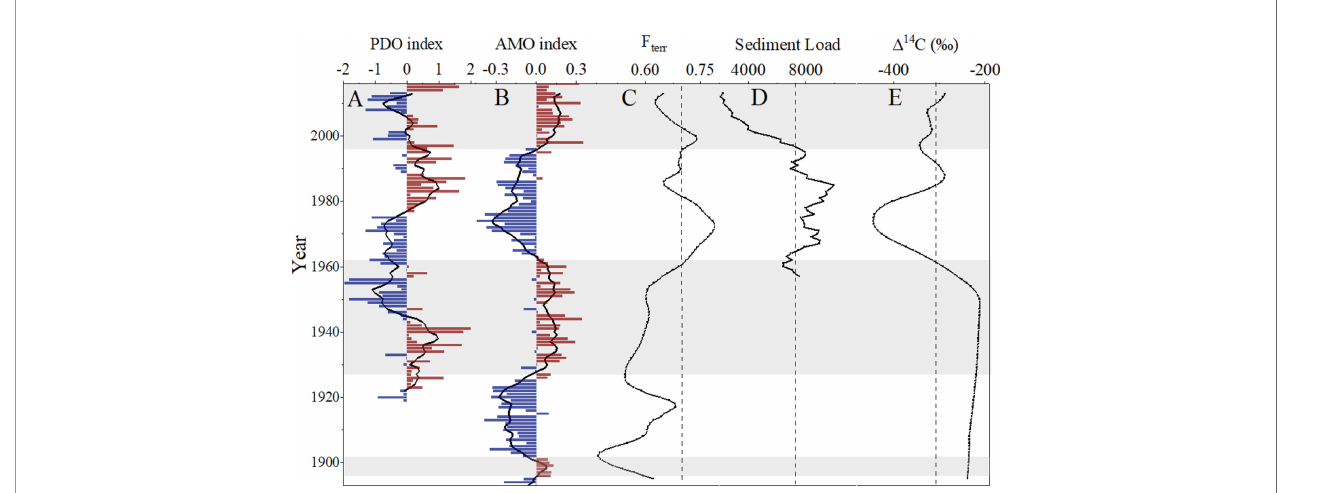
FIGURE 7 | (A) Paci fi c Decadal Oscillation (PDO) index; (B) Atlantic Multidecadal Oscillation (AMO) index; (C) Fraction of total terrestrial OC (F terr , %) from Monte Carlo simulation; (D) Sediment load (10 4 t yr -1 ) of Pearl River, modi fi ed from Wei et al. (2020); and (E ) D 14 C ( ‰ ). The interpolation method was applied for data processing. The values for the PDO index were taken from University of Washington (http://jisao.washington.edu/pdo/PDO.latest) (Duan et al., 2013). The AMO index is downloaded from Earth System Research Laboratory (http://www.esrl.noaa.gov/psd/data/correlation/amon.sm.data). The bars were annual index value. The black curves represented 7 year running mean value in (A, B) The monthly mean global average sea surface temperature (SST) anomalies have been removed to separate this pattern of variability from any global warming signal that may be present in the data (Mantua et al., 1997).